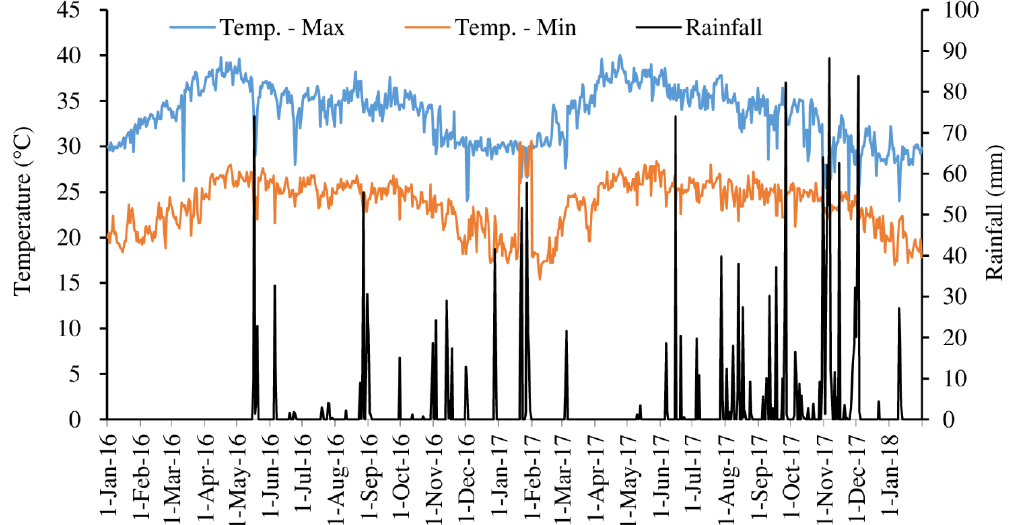
Figure 1. Daily rainfall, maximum and minimum temperature from January 2016 until January 2018 as measured at Tamil Nadu Rice Research Institute, Aduthurai, Tamil Nadu, India.